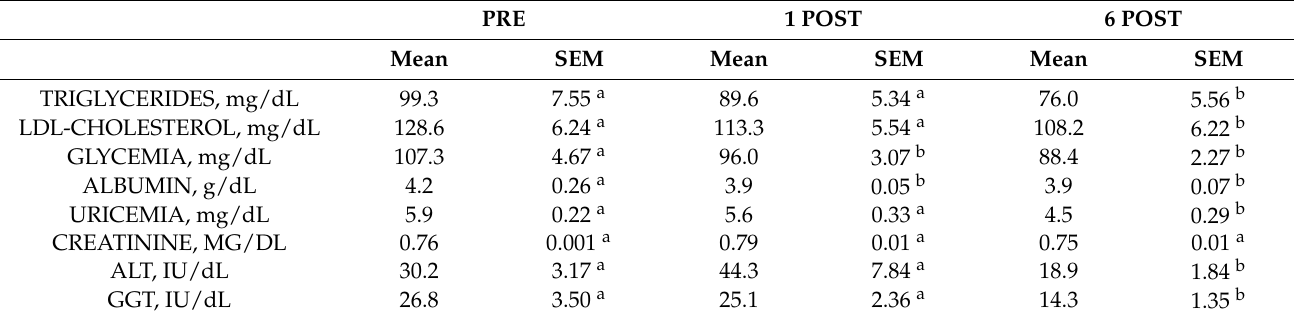
Table 2. Plasma parameters in subjects at baseline (Pre), one month (1 Post) and six months (6 Post) after bariatric surgery.